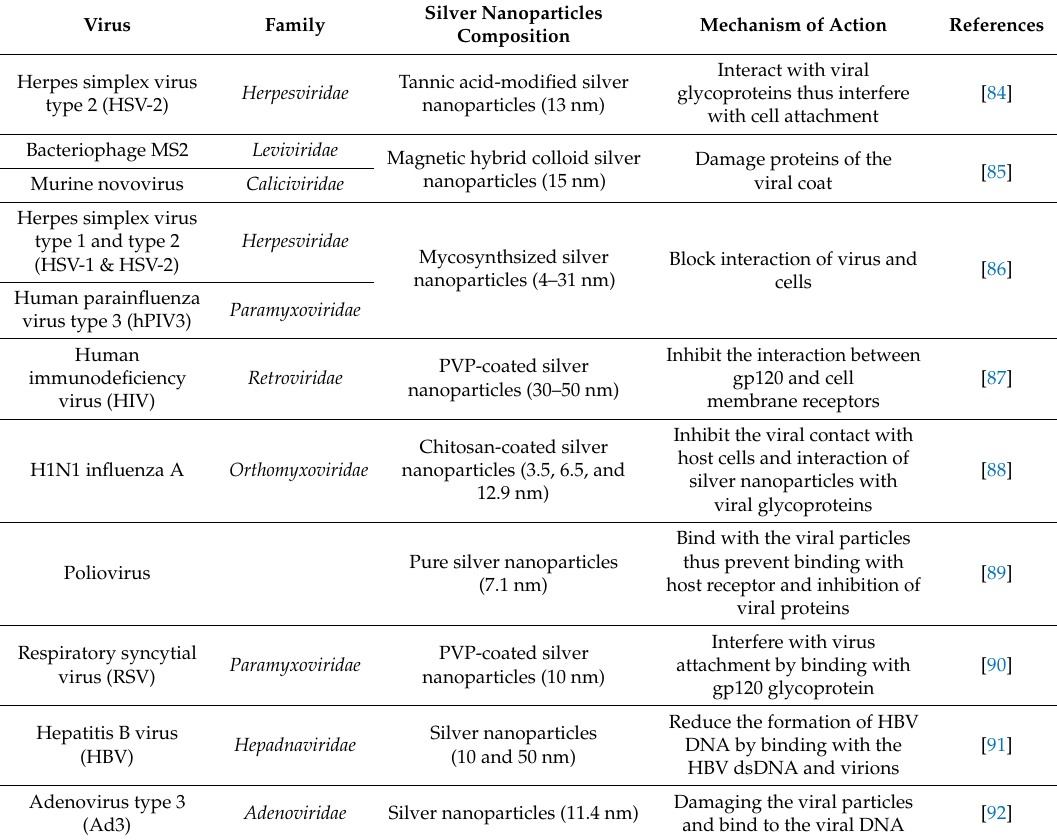
Table 5. The antiviral properties of